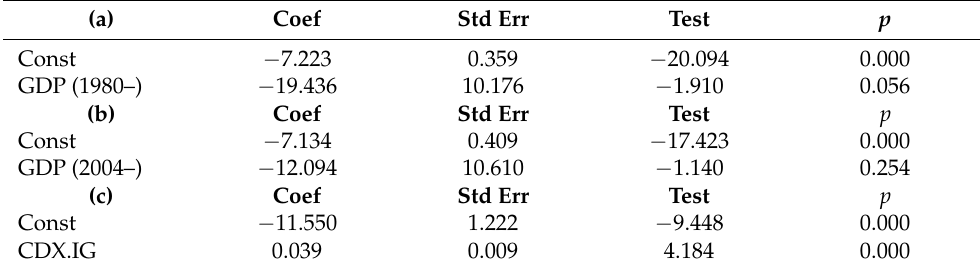
Table 2. Rating A: model parameter estimates and p -values.